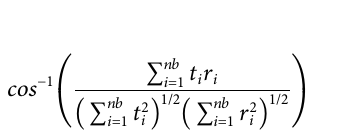
FIGURE 4 | (A) The Quebec LiDAR dataset subset to the area containing Îles-de-Boucherville National Park. (B) The resulting height mask, where the black representsareaswithaheightofgreaterthan6 m (C) frequencydistributionfortherelativeheightsof Phragmites (D) frequencydistributionfortherelativeheightsofnon - Phragmites